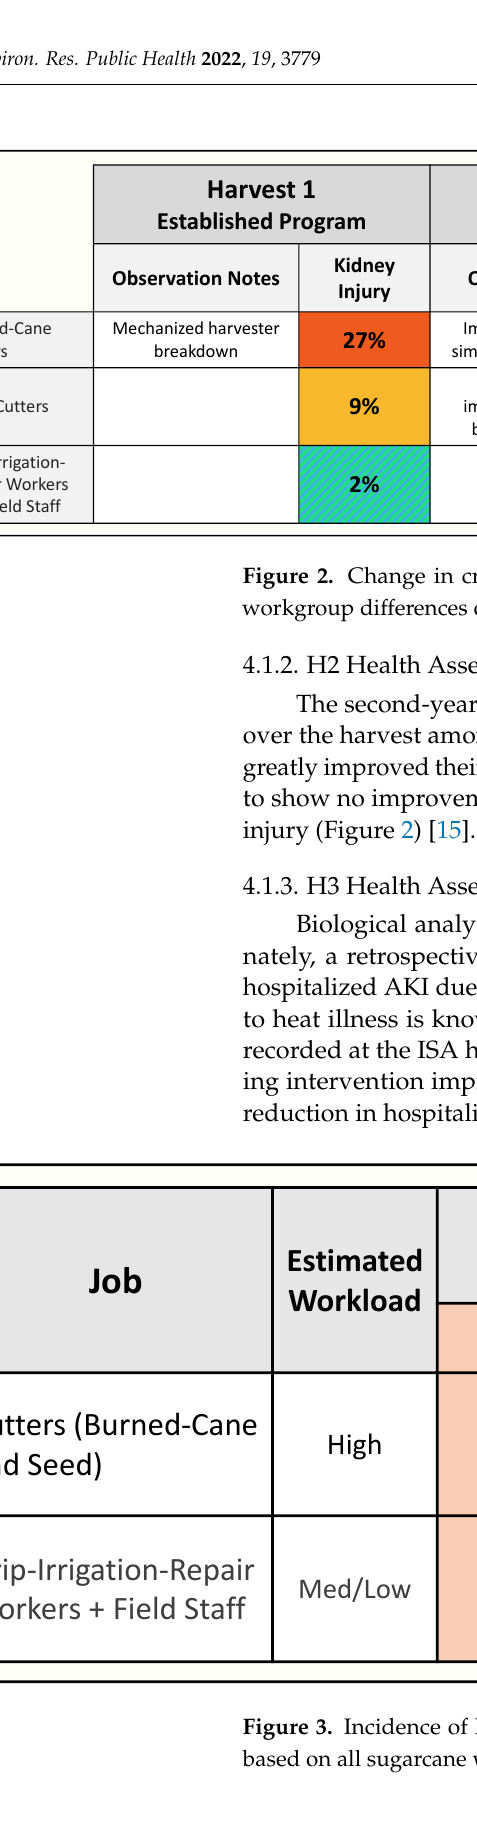
Figure 2. Change in cross-harvest kidney injury between Harvest 1 and Harvest 2. Significant workgroup differences only seen